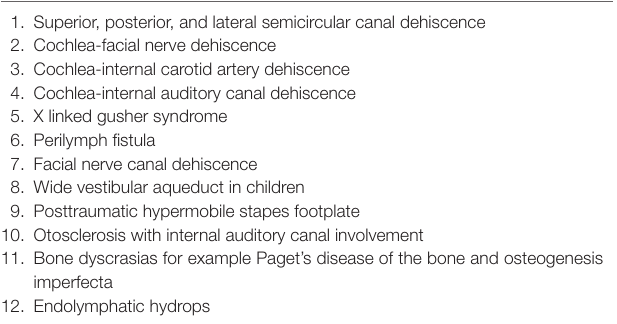
TABLE 1 | Identified third window disorders [after Wackym et al. (3), Scarpa et al.